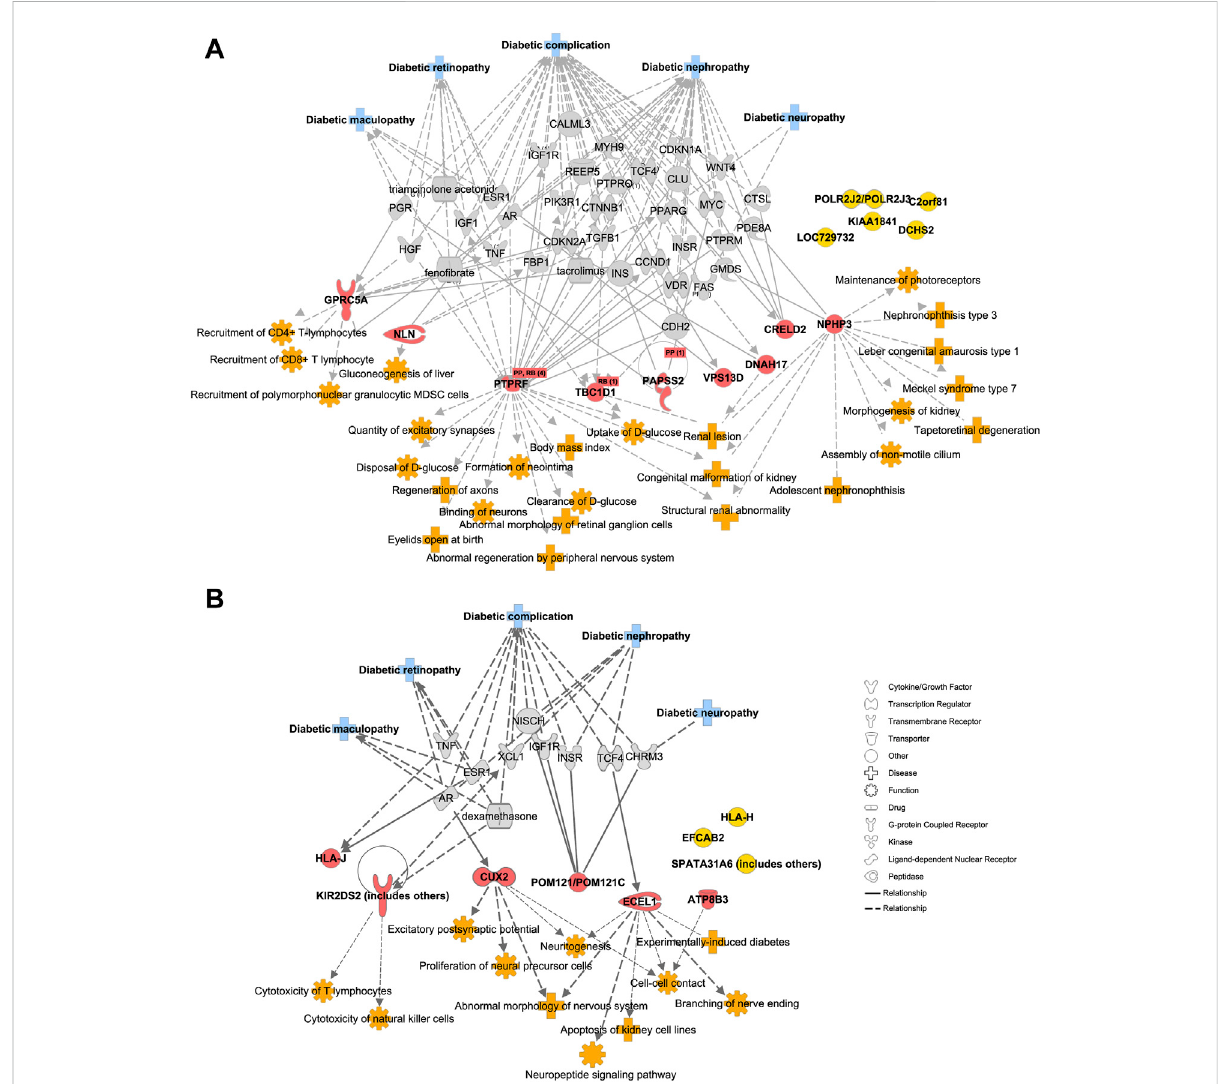
FIGURE 3 Diabetic complication-related disease and function analysis of putatively pathogenic mutant genes enriched in patients with oculopathy. (A,B) the network of diseases and functions by ingenuity pathway analysis highlights the relationships between diabetic complications and the putatively susceptible DMGs of DR vs. DM (A) and DM – DR vs. DM (B) , and functional enrichment of these genes,